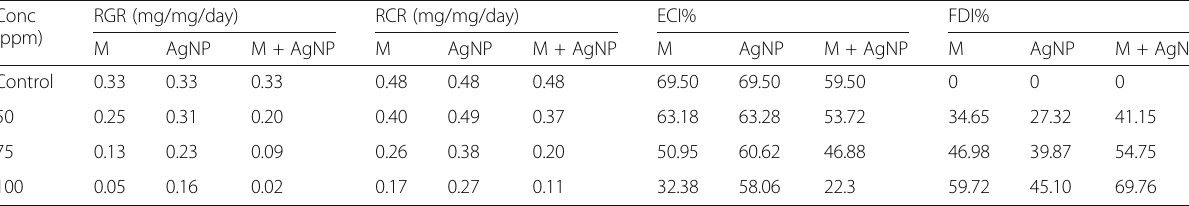
Table 6 Antifeedant activity of Tribolium castaneum against silver nanoparticles, malathion, and its combination Conc RGR (mg/mg/day) (ppm)